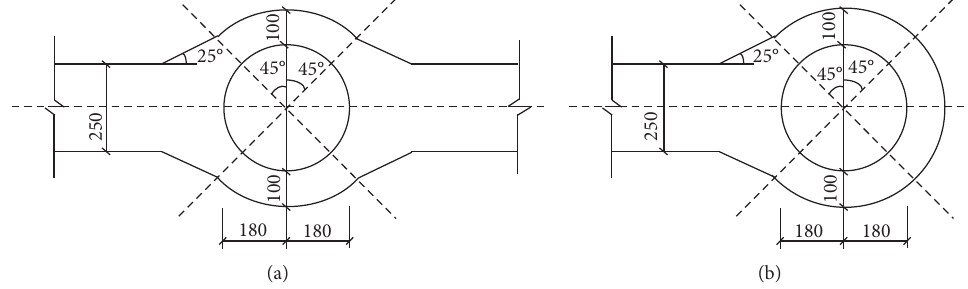
Figure 5: Joint construction (unit: mm). (a) Intermediate joint. (b) Exterior